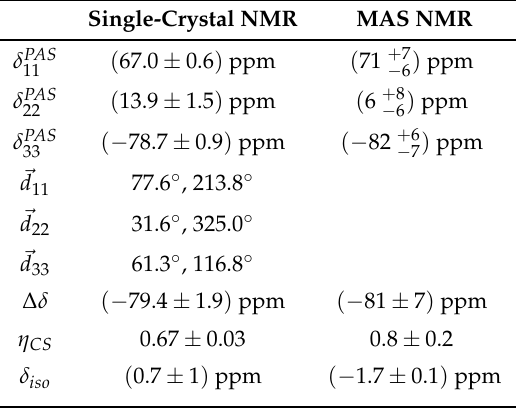
Figure 4. 31 P-NMR spectrum of polycrystalline LDP, acquired at a MAS rate of 5 kHz. The black triangle indicates the isotropic resonance at 1.7 ppm. The signal at 10.5 ppm ( ) is attributed to the − ∗ 31 P chemical shift in aqueous LiH 2 PO 4 solution. Table 1. Chemical shift (CS) tensor of 31 P in LDP, LiH 2 PO 4 , at room temperature. Left: From single-crystal NMR rotation patterns, acquired for three different rotation axes. Eigenvector orientations are listed in spherical coordinates ( θ , ϕ ) in the orthorhombic abc crystal ( CRY ) frame and refer to the atom closest to the origin, i.e., P(1). Error values are derived from the fit residuals. Right: Determined from a Herzfeld–Berger analysis [15] of the rotational side-band pattern at ν r = + 5 kHz magic-angle spinning (MAS), using the hba 1.7.5 program [16]. The error values of the tensor components are derived from those of ρ and µ